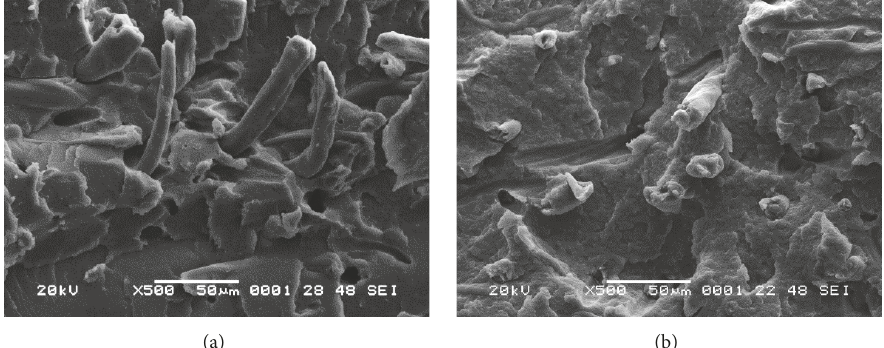
Figure 11: Fracture surface micrographs for 90/10 w/w PLA/HENCEL composites: (a) without and (b) with PLA-g-MA coupling